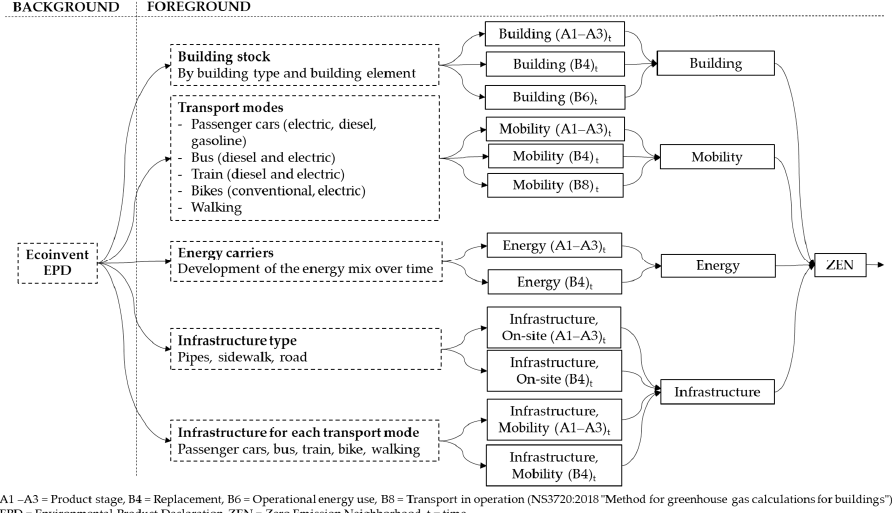
Figure 4. Outline of the different sub-systems of the LCA